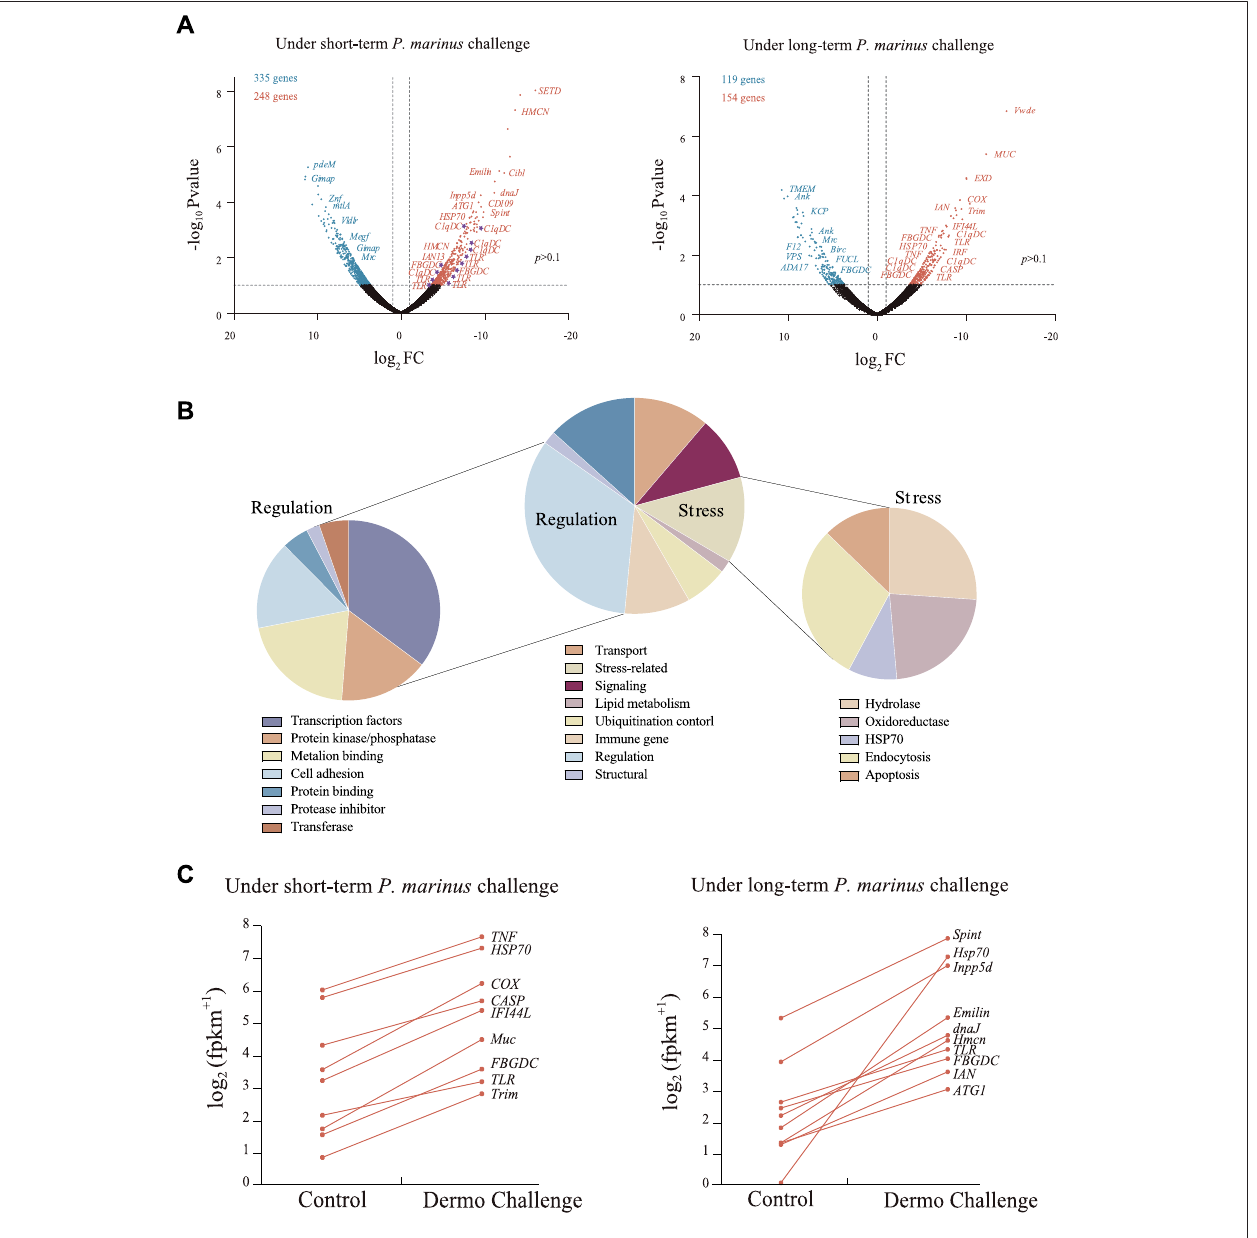
FIGURE 2 | Transcriptional changes induced by P. marinus in C. virginica. (A) , Volcano plots of transcriptional change under short-term and long-term P. marinus challenge. Blue points represent downregulated genes, red points represent upregulated genes, and black points represent non-differentially expressed genes. (B) , Functional annotation of differentially expressed genes under P. marinus challenge. (C) , Immune-related genes signi fi cantly up-regulated after dermo challenge.